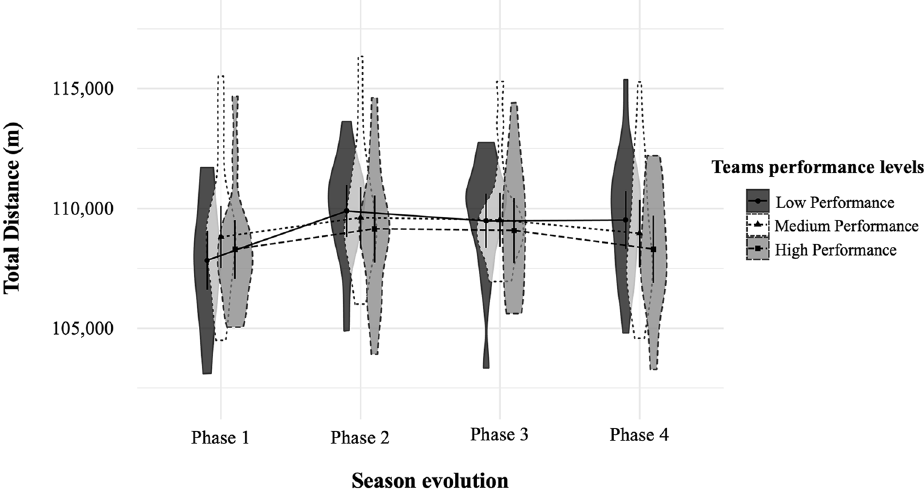
Figure 1. Total distance covered in meters ( M ± SD ) by teams with high, medium and low performance in the different phases of the seasons 29 . m